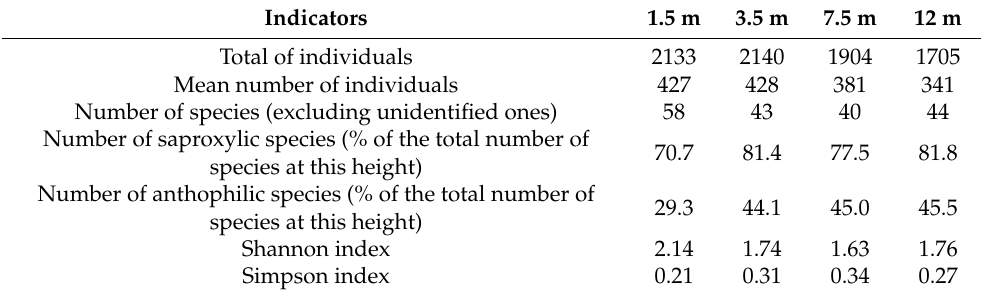
Table 1. The main indicators of Coleoptera individuals collected using beer traps at different heights.